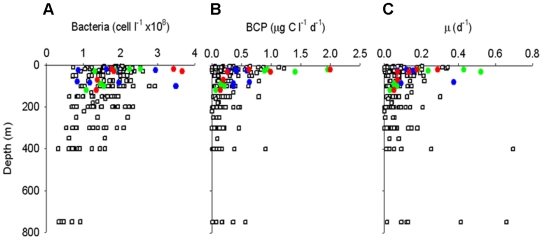
Depth profile of bacterial parameters in summer 2004 and winter 2006.Winter data are from 32 stations from 5 to 400 m; at 6 stations samples were also taken from 750 m. Summer: blue circles = ACC water; red circles = shelf water; green circles = mixed water; empty square = Winter. (Panel A) Bacterial abundance; (panel B) BCP = bacterial carbon production; BCP calculated from 3H-Leucine incorporation, employing a conversion factor of 3.1 kg C per mol of Leu [17]; (panel C) μ = bacterial growth rate. Cell-specific growth rate calculations assumed 20 fg C per cell [18].